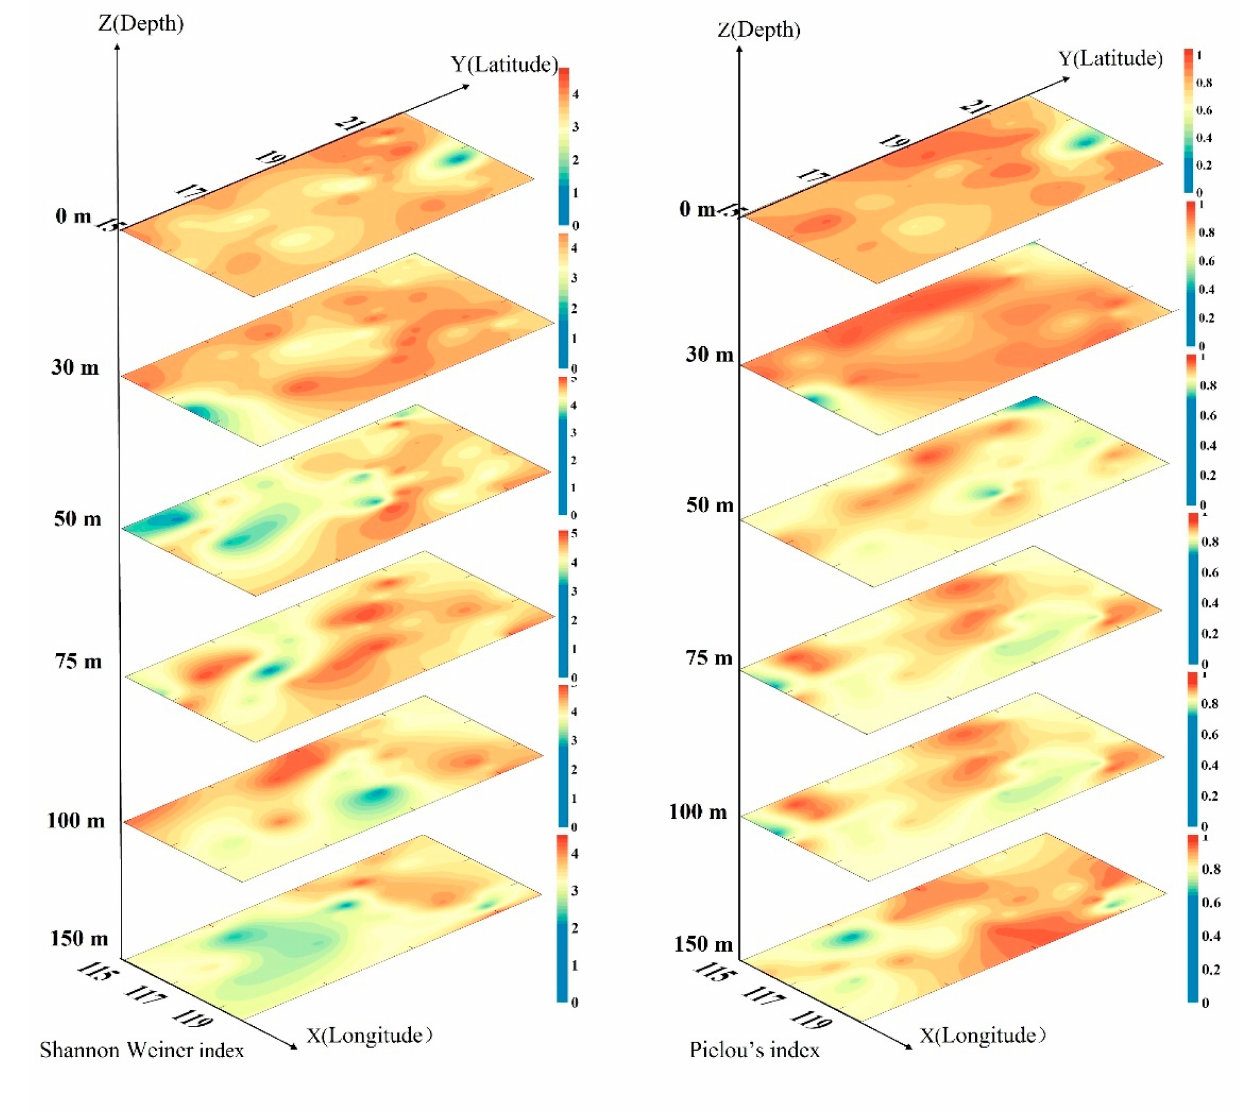
Figure 6. Shannon Weiner and Pielou indices in the six layers of sampling stations in the northern South China